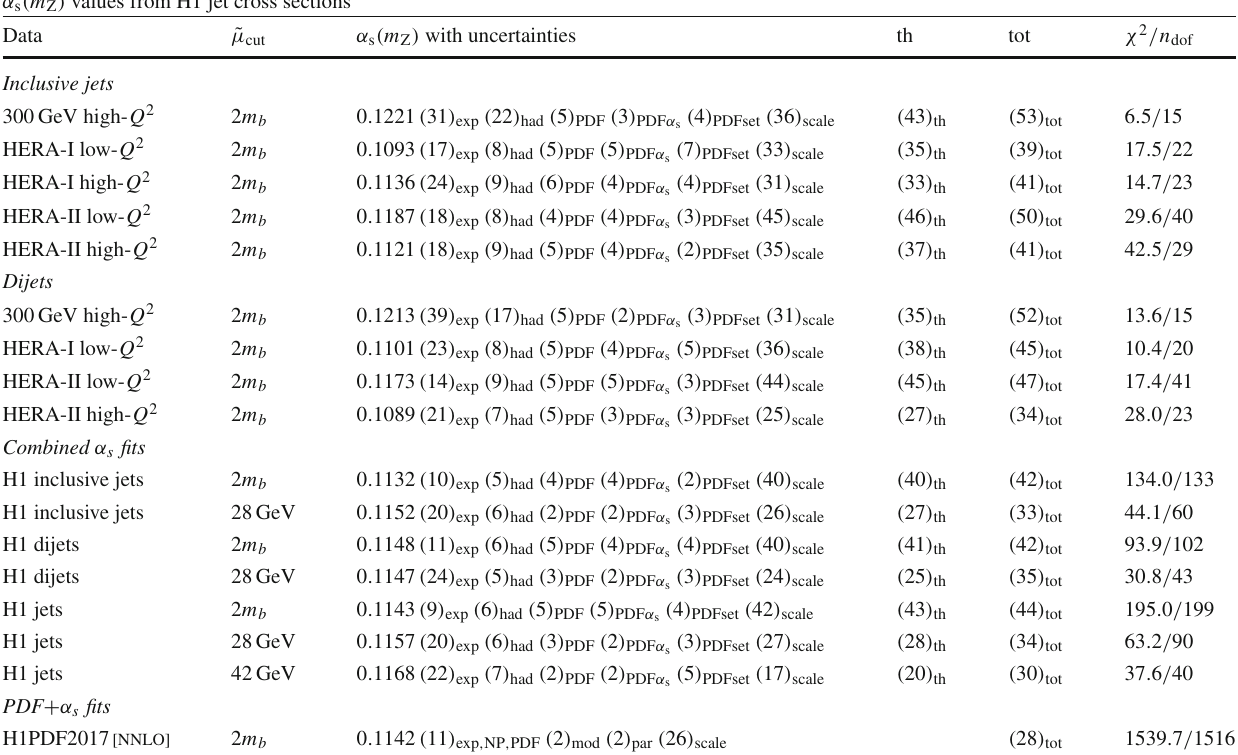
Table 4 Summary of values of α s ( m Z ) from fits to H1 jet cross sec- tion measurements using NNLO predictions. The uncertainties denote the experimental (exp), hadronisation (had), PDF, PDF α s , PDFset and scale uncertainties as described in the text. The rightmost three columns denote the quadratic sum of the theoretical uncertainties (th), the total (tot) uncertainties and the value of χ 2 / n dof of the corresponding fit. Along the vertical direction, the table data are segmented into five parts. The uppermost part summarises fits to individual inclusive jet datasets. The second part corresponds to fits of the individual dijet datasets. The